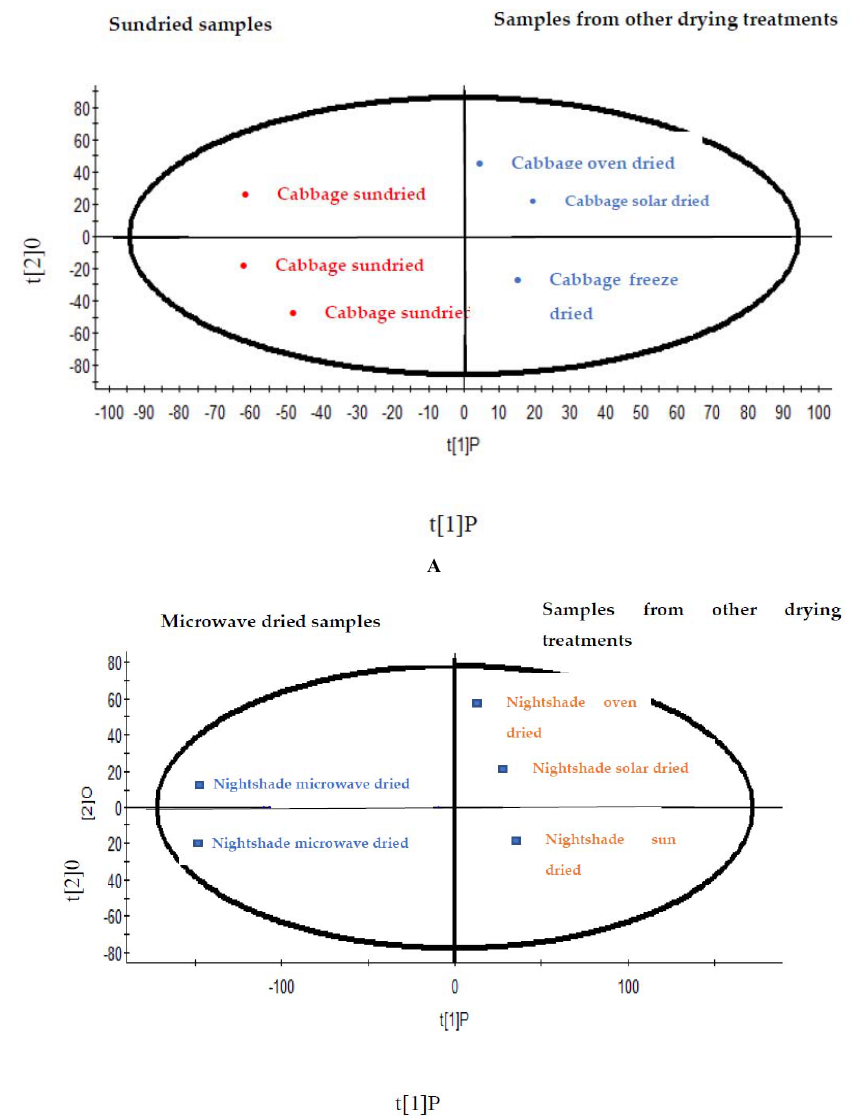
Figure 1 ( A ) Score plot of Principal component analysis (unsupervised) based on UPLC – Q ‐ TOF/MS spectra of different drying treatments Chinese cabbage leaves. ( B ) Score plot of Principal component analysis (unsupervised) based on UPLC – Q ‐ TOF/MS spectra of different drying treatments of Nightshade leaves.